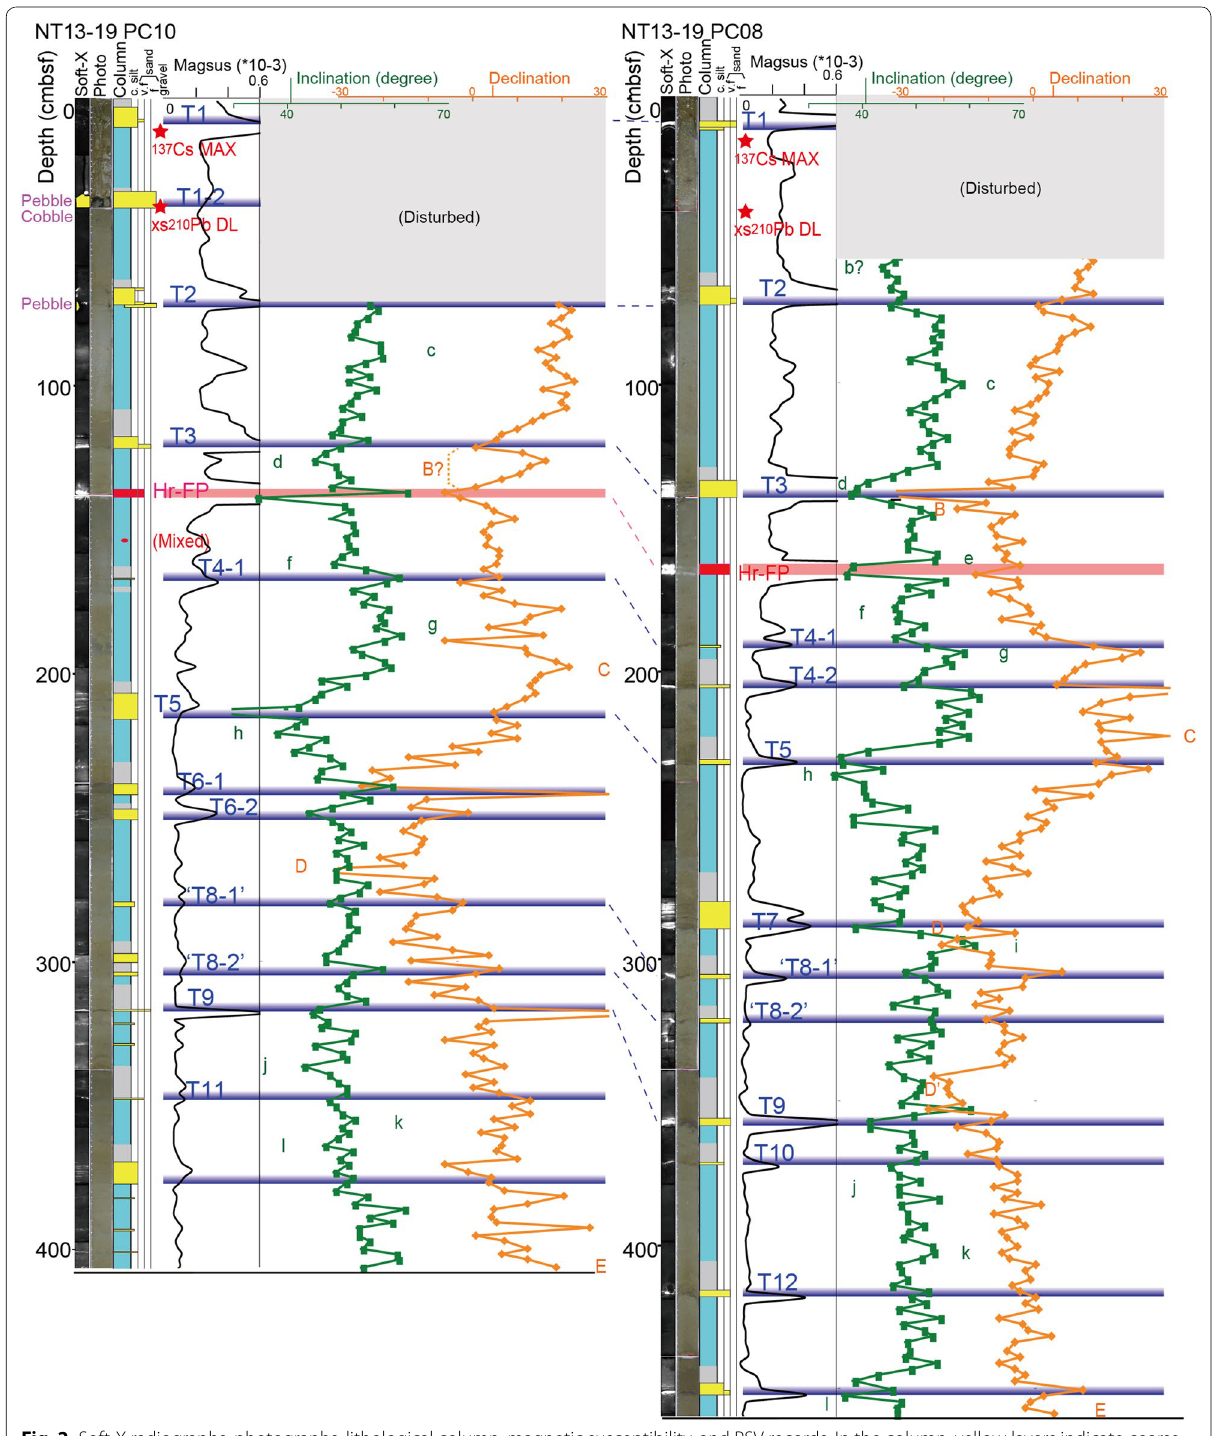
Fig. 2 Soft-X radiographs, photographs, lithological column, magnetic susceptibility, and PSV records. In the column, yellow layers indicate coarse layers (> course silt); blue layers are hemipelagite (silt ~ clay); gray horizons are turbidite-mud; red layers and patch are tephra layers or patches. Apparent turbidites (event deposits) are indicated by blue lines, and are numbered beginning at the top layer. Relatively indistinct turbidites are assigned branch numbers. The letters “A”–“E” (relative declination) and “a”–“l” (inclination) added to the PSV records are PSV labels for prominent features of age control (Kanamatsu et al. 2017). Shaded intervals of the PSV record are horizons disturbed by inclinations of minimum axes of anisot- ropy of magnetic susceptibility (Kanamatsu et al. 2017). Stars indicate horizons at the excess 210 Pb detection limit and the 137 Cs maximum (McHugh et al.